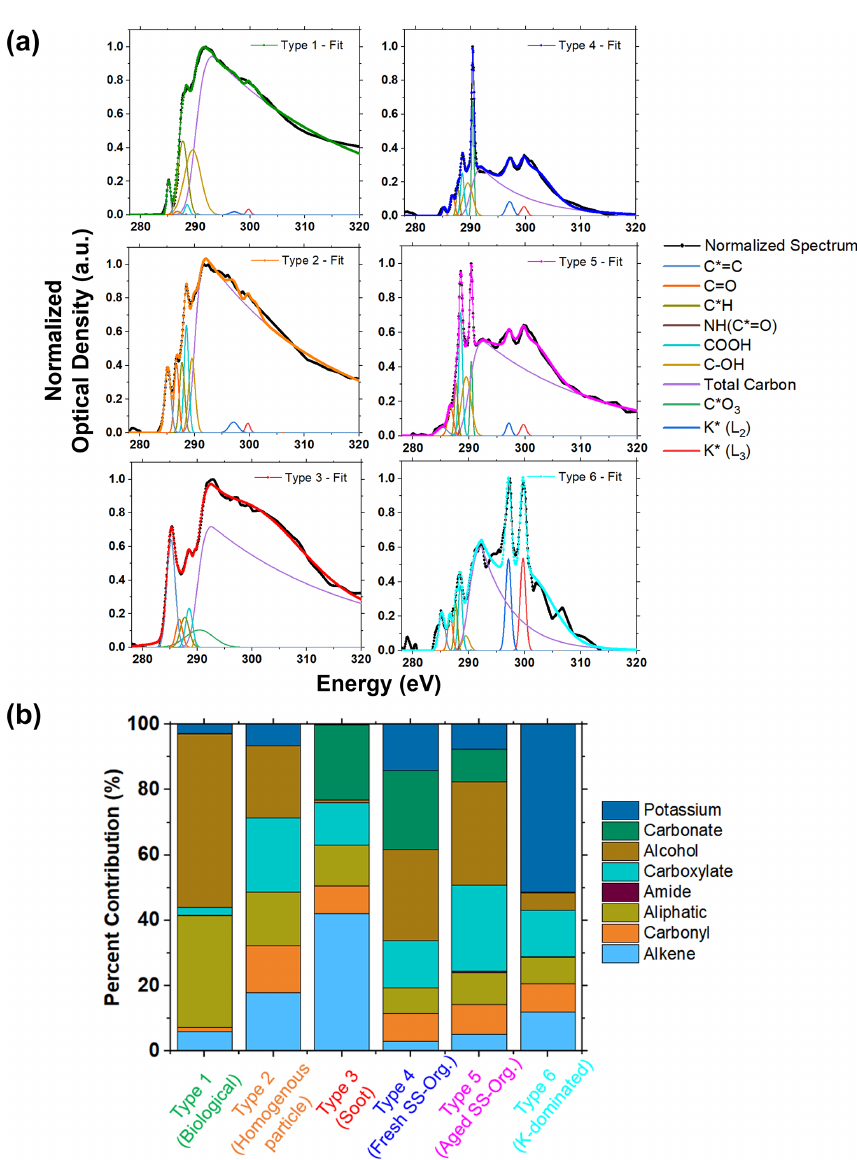
Figure 5. (a) Carbon K-edge NEXAFS spectra of six carbon types identified in individual particles: type 1 – biological (green), type 2 – homogeneous organic particles (orange), type 3 – soot (red), type 4 – fresh sea salt–organics (blue), type 5 – aged sea salt–organics (pink), type 6 – K-dominated salt (teal). (b) The contributions of the different carbon functional groups are reported as a percentage of the total peak